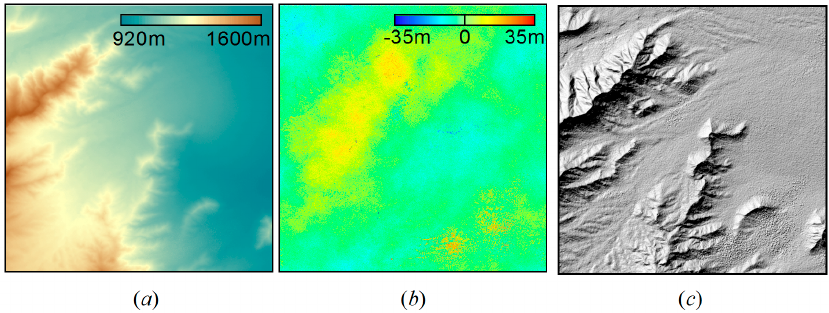
Figure 5. ( a ) Multi-baseline InSAR DEM with prior DEM (with atmospheric effects); ( b ) height error map; ( c ) is the hillshade map of ( a ).